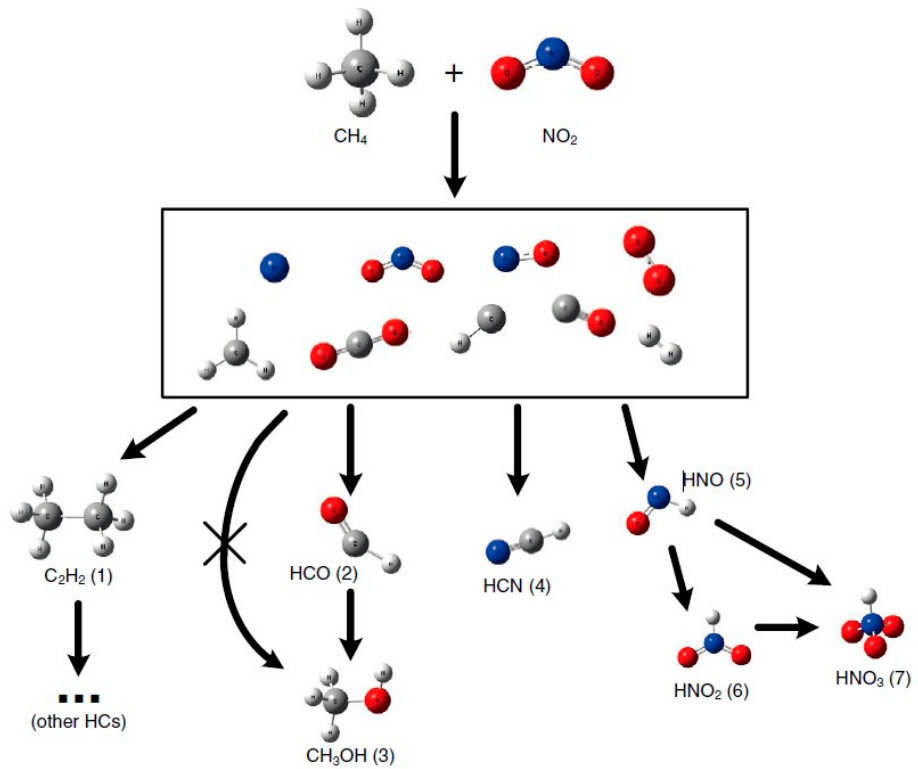
Figure 20. Schematic diagram of the products of CH 4 /N 2 O reaction using non-thermal plasma. Reproduced with permission from [136]. Copyright 2015 Elsevier.